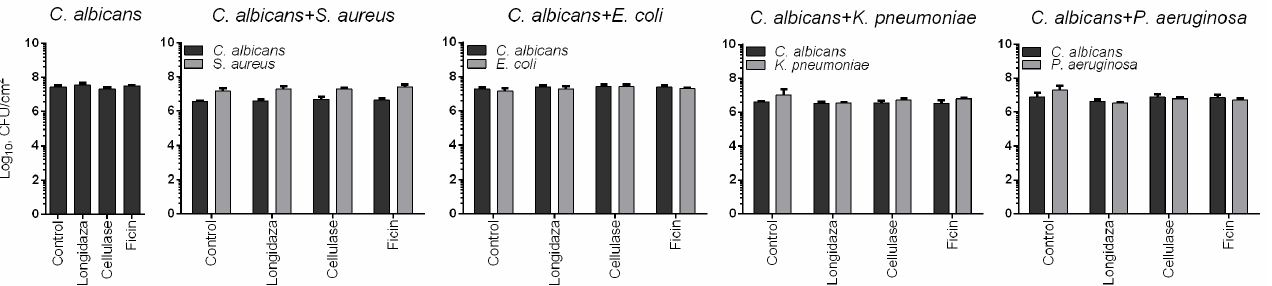
Figure 5. The effect of Longidaza ® on CFUs count in C. albicans and fungal–bacterial biofilms. Forty-eight-h-old biofilms were washed and incubated 24 h in fresh BM broth supplemented with 750 IU of Longidaza ® as indicated. After 24 h incubation, the biofilms were washed twice with sterile 0.9% NaCl. The adherent cells were scratched, resuspended, and CFUs were counted.